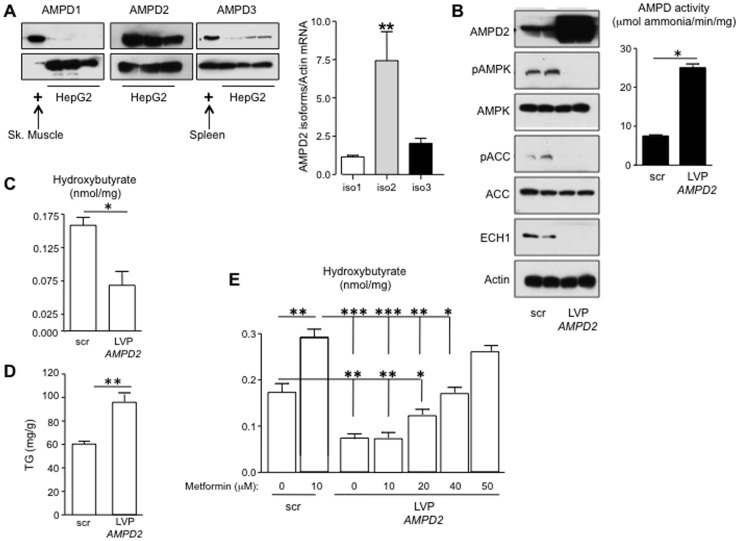
Metformin regulates AMPD2 activity in human hepatocytes.A) AMPD2 is the main isoform in HepG2 cells. The expression of AMPD1 and AMPD3 isoforms is minimal compred to AMPD2. Skeletal muscle and spleen are positive controls for AMPD1 and AMPD3 expression, respectively. Quantitative PCR analysis (bottom) demonstrates that isoform 2 is the predominant isoform of AMPD2. **p<0.01 versus isoforms 1 and 3. B) Over-expression of AMPD2 down-regulates the activation of AMPK. Transduction of HepG2 cells with lentiviral particles codifying for the isoform 2 of AMPD2 results in significantly higher levels of AMPD2 protein expression as well as AMPD activity. This is paralleled with reduced levels Thr172 pAMPK expression as well as of their target genes ECH1 and Ser79 pACC. *p<0.05 C–D) Reduction in ECH1 expression in over-expressing AMPD2 hepatocytes is accompanied with lower intracellular β-hydroxybutyrate and higher TG levels. *p<0.05, **p<0.01 E) Over-expression of AMPD2 impairs metformin-induced fat oxidation. Metformin 10 µM significantly increased β- hydroxybutyrate levels in cells transducted with scramble RNA. In contrast, no significant change was observed with 10 µM metformin in cells overexpressing AMPD2. Metformin 50 µM significantly increased β- hydroxybutyrate to levels observed in scramble transducted cells *p<0.05, **p<0.01, ***p<0.001.